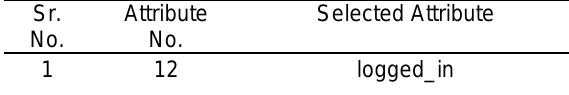
Table 3. Top 14 ranked features using Gain Ratio Feature Evaluation